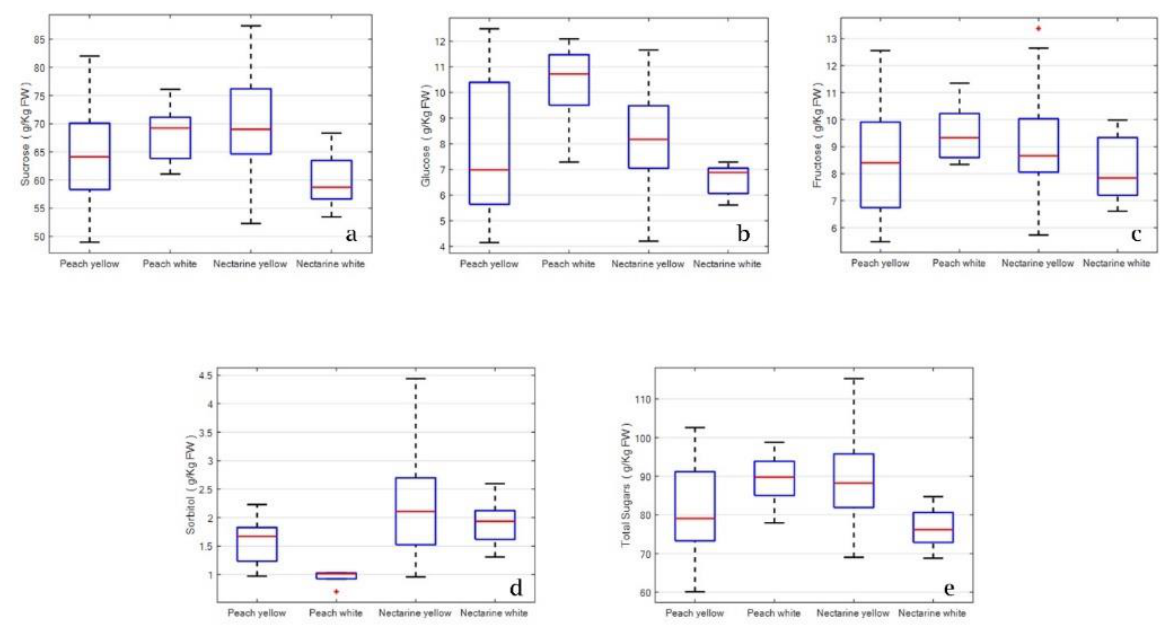
Figure 3. Box plots for sugars content of different types of peaches and nectarines fruits: ( a ) sucrose content; ( b ) glucose content; ( c ) fructose content; ( d ) sorbitol content; ( e ) total sugars. The central